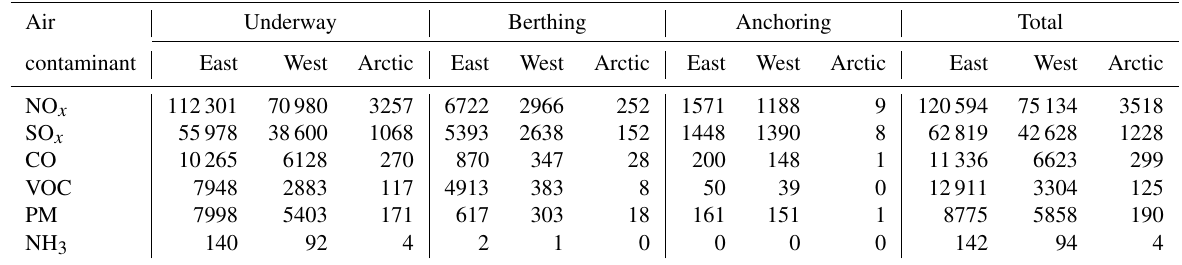
Table 2. 2010 marine emission estimates (in tonnes) for Canada’s waters by activity mode and by regions. Air Underway Berthing Anchoring Total contaminant East West Arctic SO